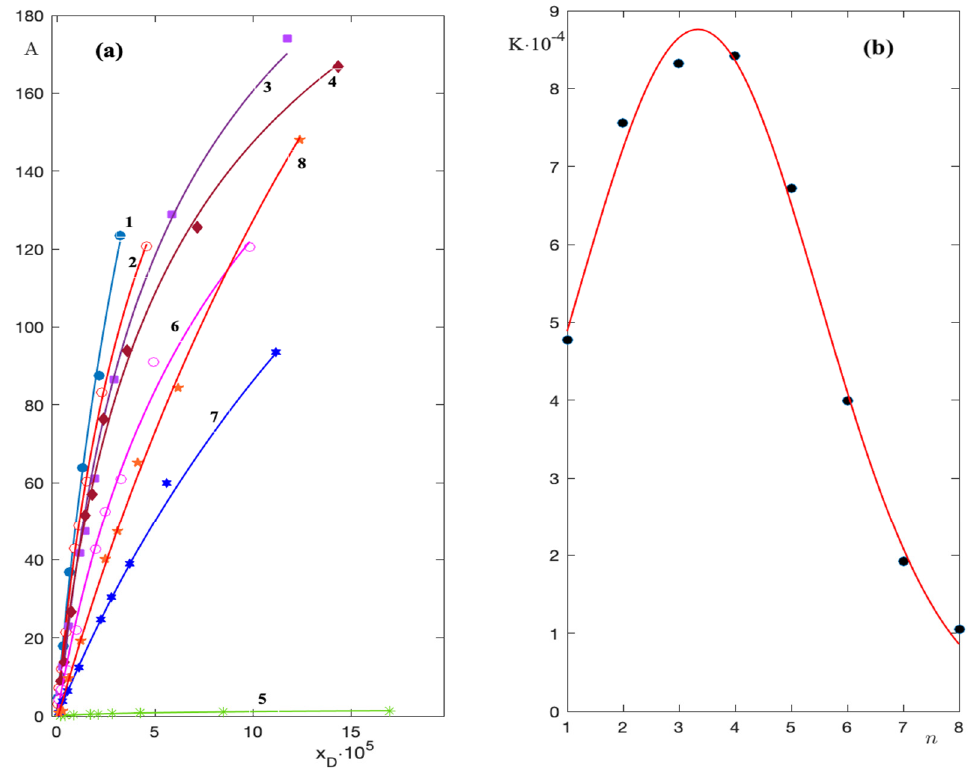
Figure 2. ( a ) Integral absorbance of NR in H − (CH 2 ) n − OH ( n = 1 − 8) solutions as a function of alkanol mole fraction. The number of carbon atoms is shown on each experimental curve. ( b ) The dimerization constant, calculated by Equation (20), as a function of the number of carbon atoms.